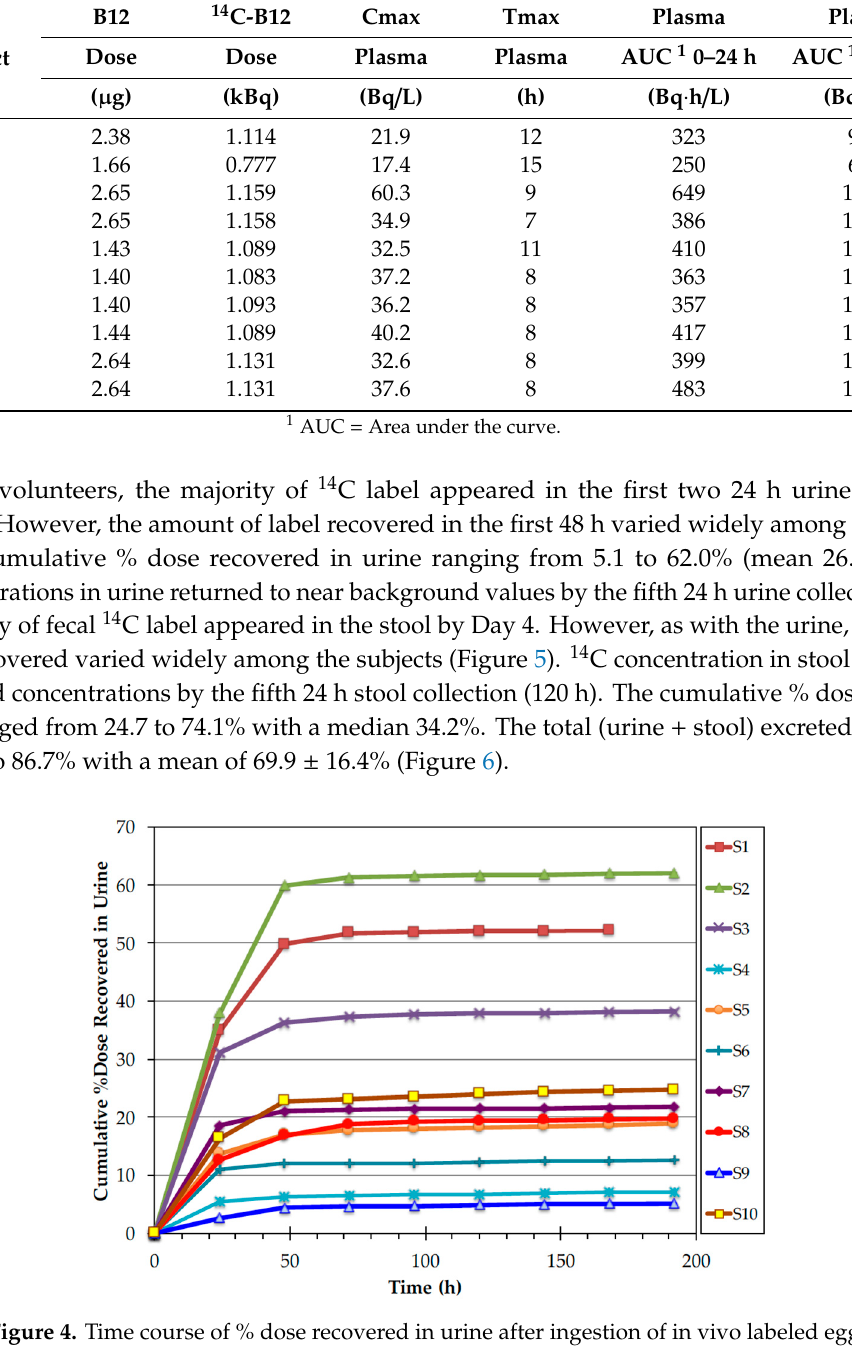
Table 2. Plasma absorption and clearance parameters for study subjects S1–S10.